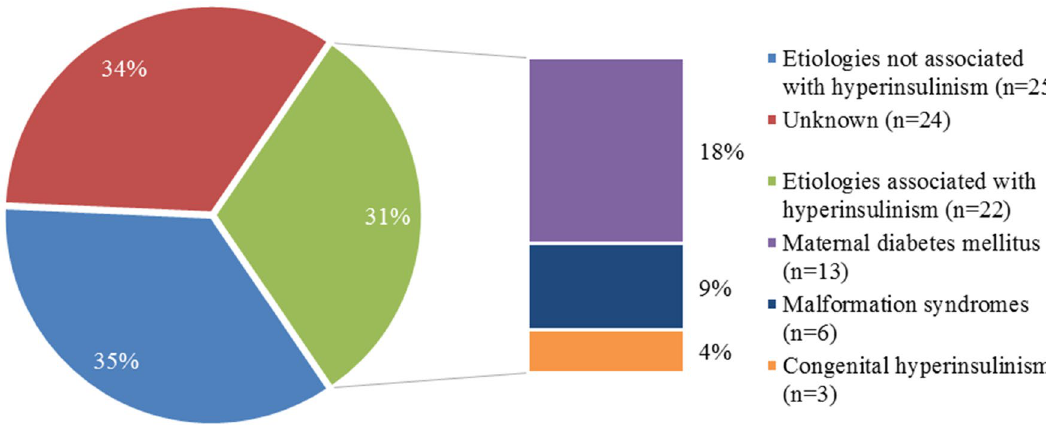
Figure 2. Underlying etiologies of cardiac hypertrophy in infants associated with hyperinsulinism. Malformation syndromes associated with hyperinsulinism: Costello (n = 2), Beckwith–Wiedeman (n = 1), Leprechaunism (n = 1), Berardinelli–Seip Congenital Lipodystrophy (n =